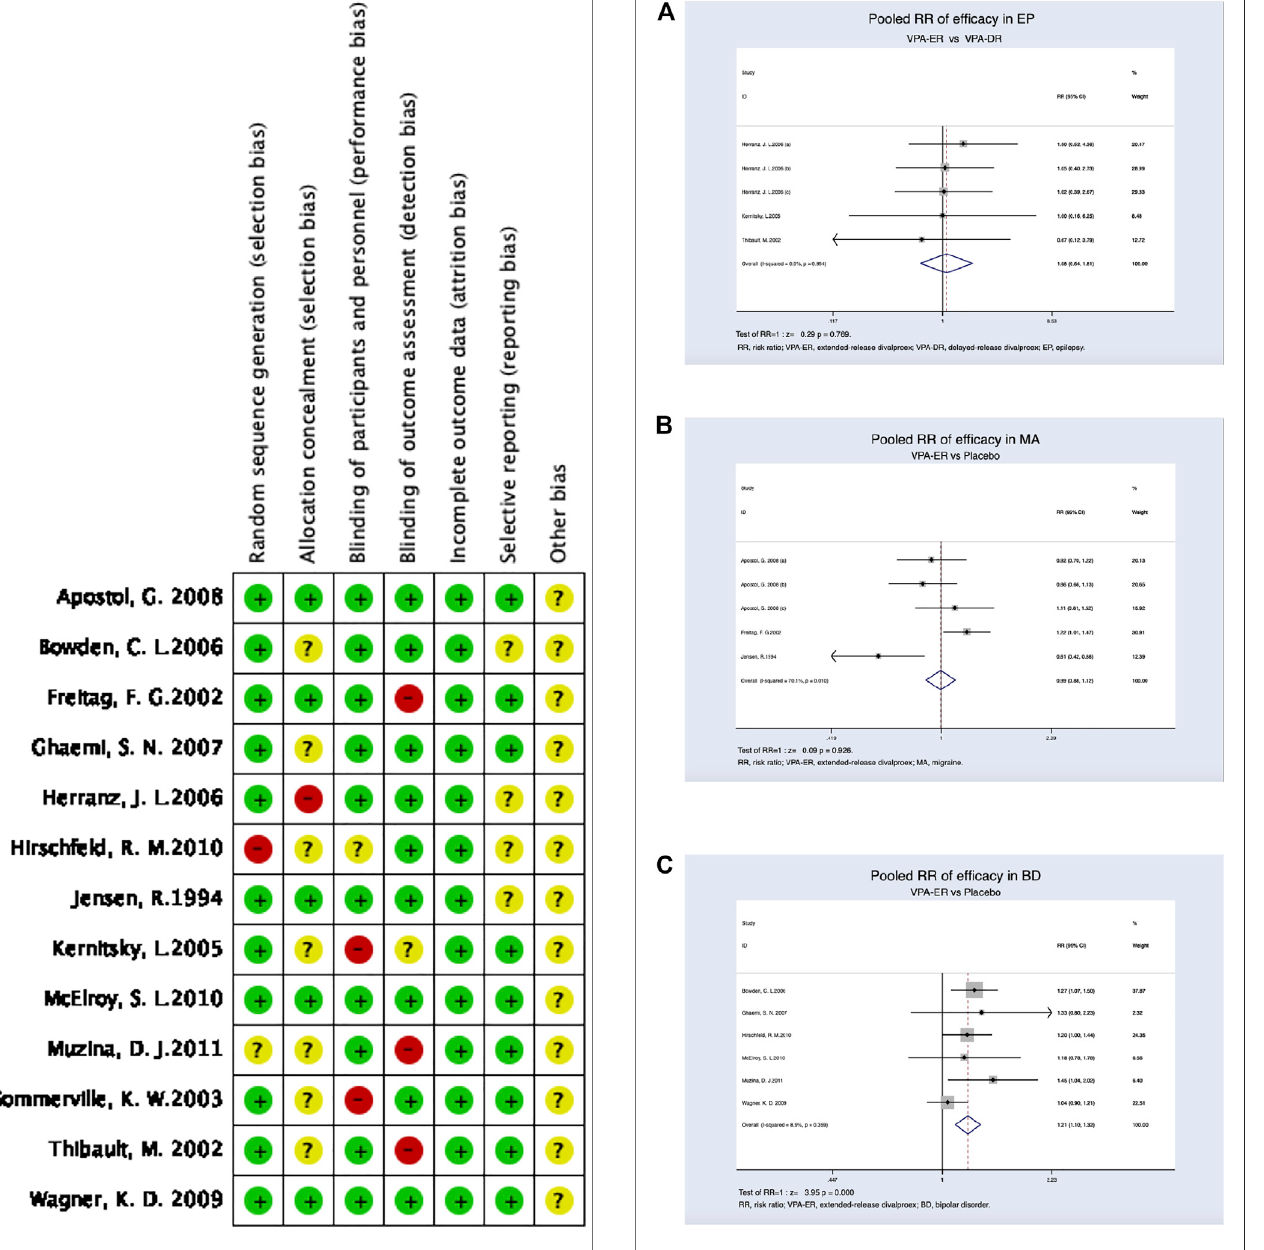
FIGURE 2 | Risk of bias summary. FIGURE 3 | (A) Pooled RR of ef fi cacy between VPA-ER with VPA-DR in EP. (B) Pooled RR of ef fi cacy between VPA-ER with placebo in MA. (C) Pooled RR of ef fi cacy between VPA-ER with placebo in